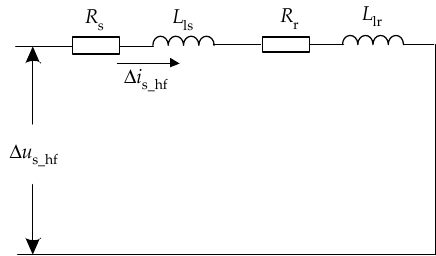
Figure 10. Equivalent circuit of the injected high frequency AC component for the IM.